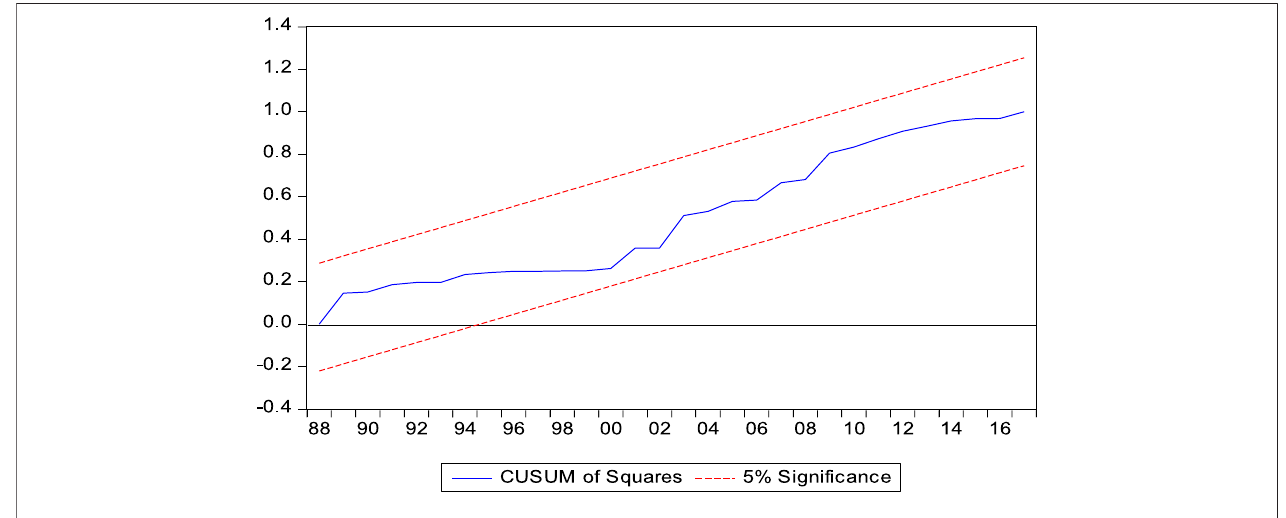
FIGURE 1 | CUSUM and RS-CUSUM tests results.